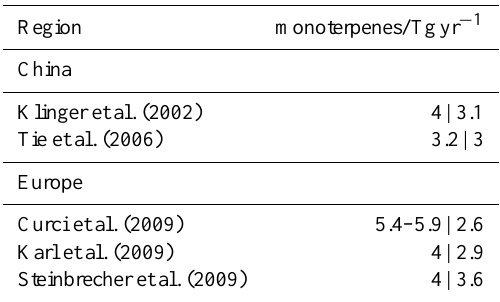
Table 5. Comparison of monoterpene emissions from regional stud- ies (left) and MEGAN–MACC (right). MEGAN–MACC emissions were extracted for the particular region and period of the regional